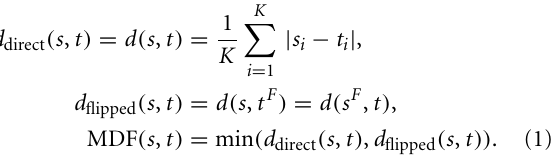
FIGURE 2 |The principal distance used in this work is minimum average direct-flip distance MDF = min( d direct , d flipped ) which is a symmetric distance function that can deal with the streamline bi-directionality problem; it works on streamlines which have the same number of points. Another distance we use is the mean average distance which is again symmetric but does not require the streamlines to have the same number of